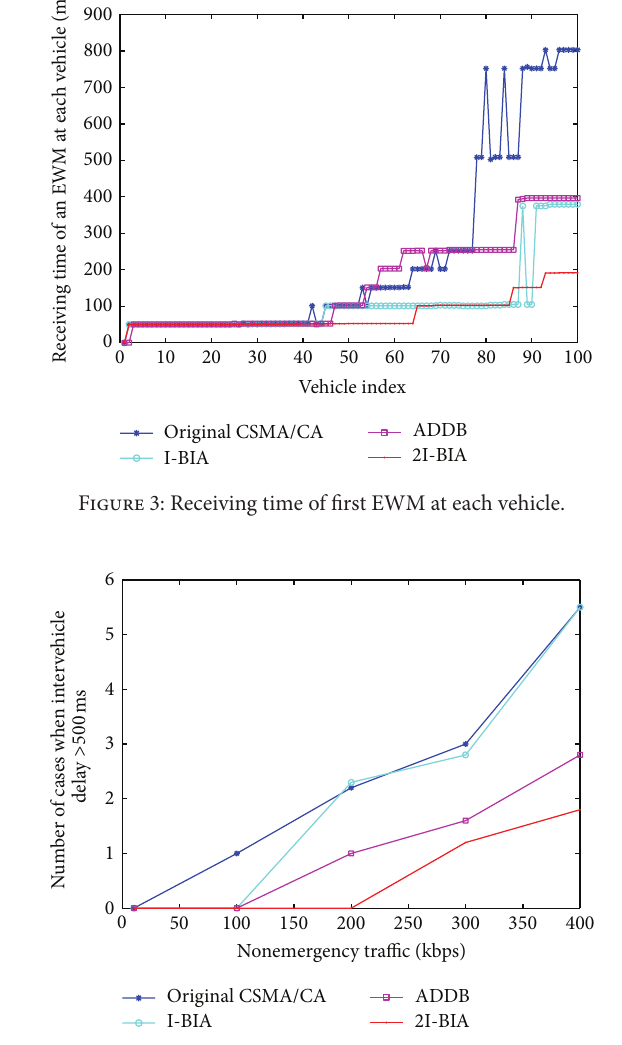
Figure 4: Number of cases where intervehicle delay is ≥ 500